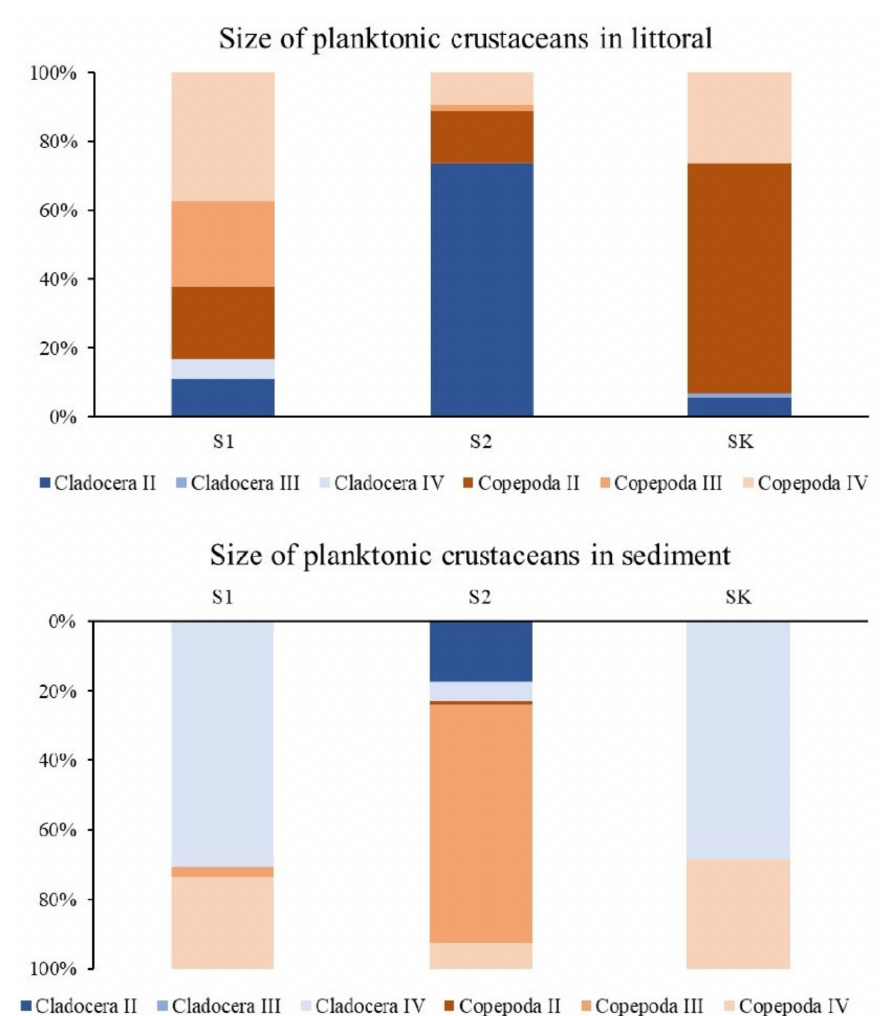
Figure 5. Relative abundance of body size categories of planktonic crustaceans in the littoral water zone and sediment. Size ranges of categories are given in the Section